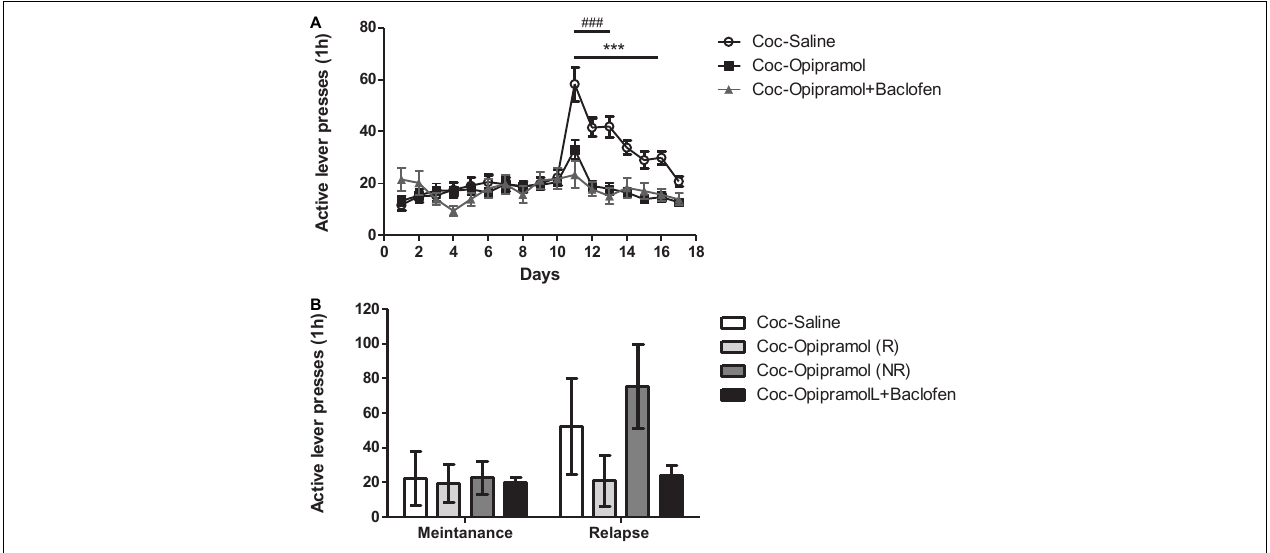
FIGURE 3 | Effect of the combination of opipramol and baclofen on extinction, withdrawal and reinstatement phases in a cocaine (Coc) self-administration rat (SA) model. (A) Effect of the selected treatment; opipramol (12.5 mg/kg) or opipramol (12.5 mg/kg) and baclofen (0.1 mg/kg) combination on cocaine-seeking during extinction and withdrawal phases. Opipramol alone and the combination treatments given on days 11–17 significantly reduced cocaine-seeking behavior during extinction training, compared with saline-treated controls. A two-way ANOVA with repeated measures revealed a significant effect of treatment [ F (2, 1712) = 7.42, p = 0.001], time [ F (16, 1712) = 16.97, p < 0.0001] and the interaction between them [ F (32, 1712) = 7.75, p < 0.0001]. (Bonferroni, *** p < 0.001 days 11–16 opipramol treatment vs. controls, ### p < 0.001 days 11–13 O/B treatment vs. controls). (B) Effect of opipramol or the combination of O/B on cocaine-primed reinstatement. Active lever presses were decreased in rats that were responders (R) to opipramol [Coc-Opipramol (R)] and in rats that received O/B combination (Coc-Opipramol + Baclofen) compared with opipramol non-responder (NR) rats [Coc-Opipramol (NR)] and controls (Coc-Saline). A one-way ANOVA revealed a significant effect of treatment [ F (3, 89) = 28.97, p < 0.0001] in the relapse test (Bonferroni, *** / ### p < 0.001 opipramol responders and O/B vs. non-responders and controls, respectively). Values are expressed as mean ±